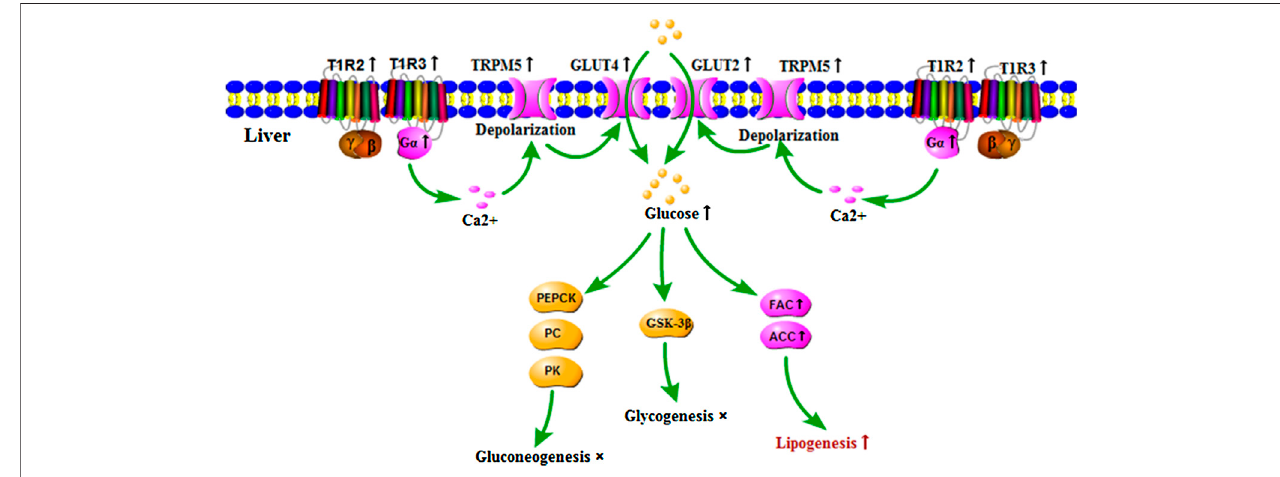
FIGURE 5 | Regulatory role of APS on expressions of signaling molecules in STRs pathway and genes of glucose and lipid metabolism in the liver of T2DM rats. ↑ : indicated that APS up-regulated gene expressions and biological process of T2DM rats, ×: indicated that no signi fi cant in fl uence of APS on biological process of T2DM